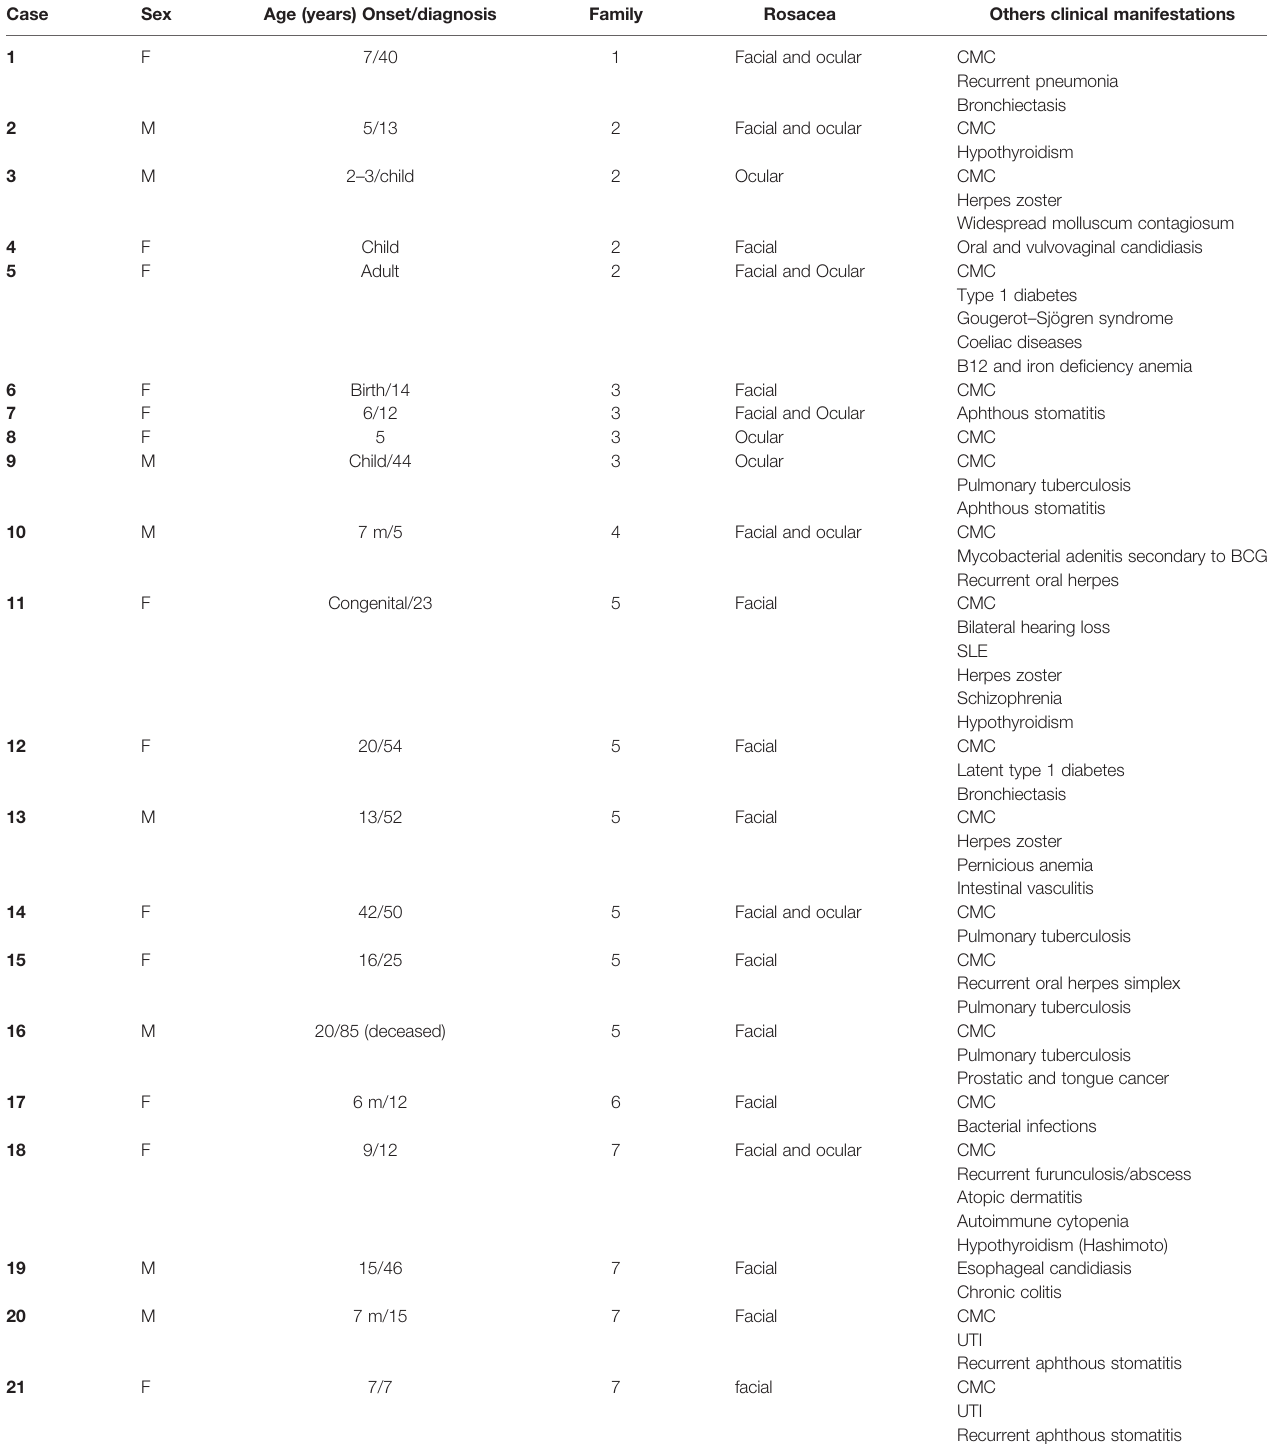
TABLE 1 | Clinical characteristics of the 19 patients with rosacea and STAT1 GOF